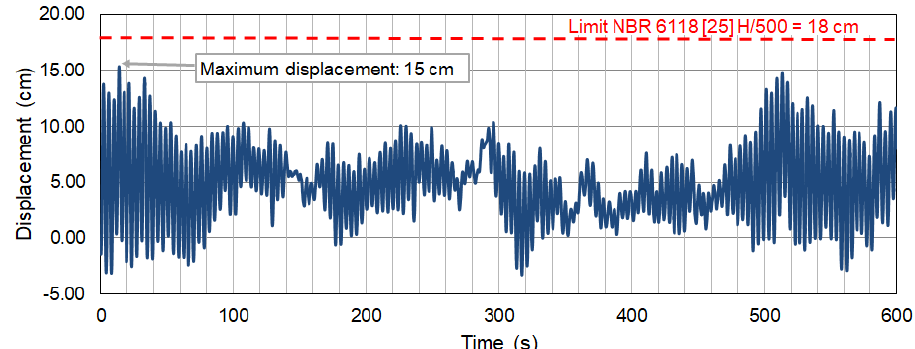
Figure 11. Example of translational horizontal displacement result at 90 meters high (period of recurrence of 10 years).